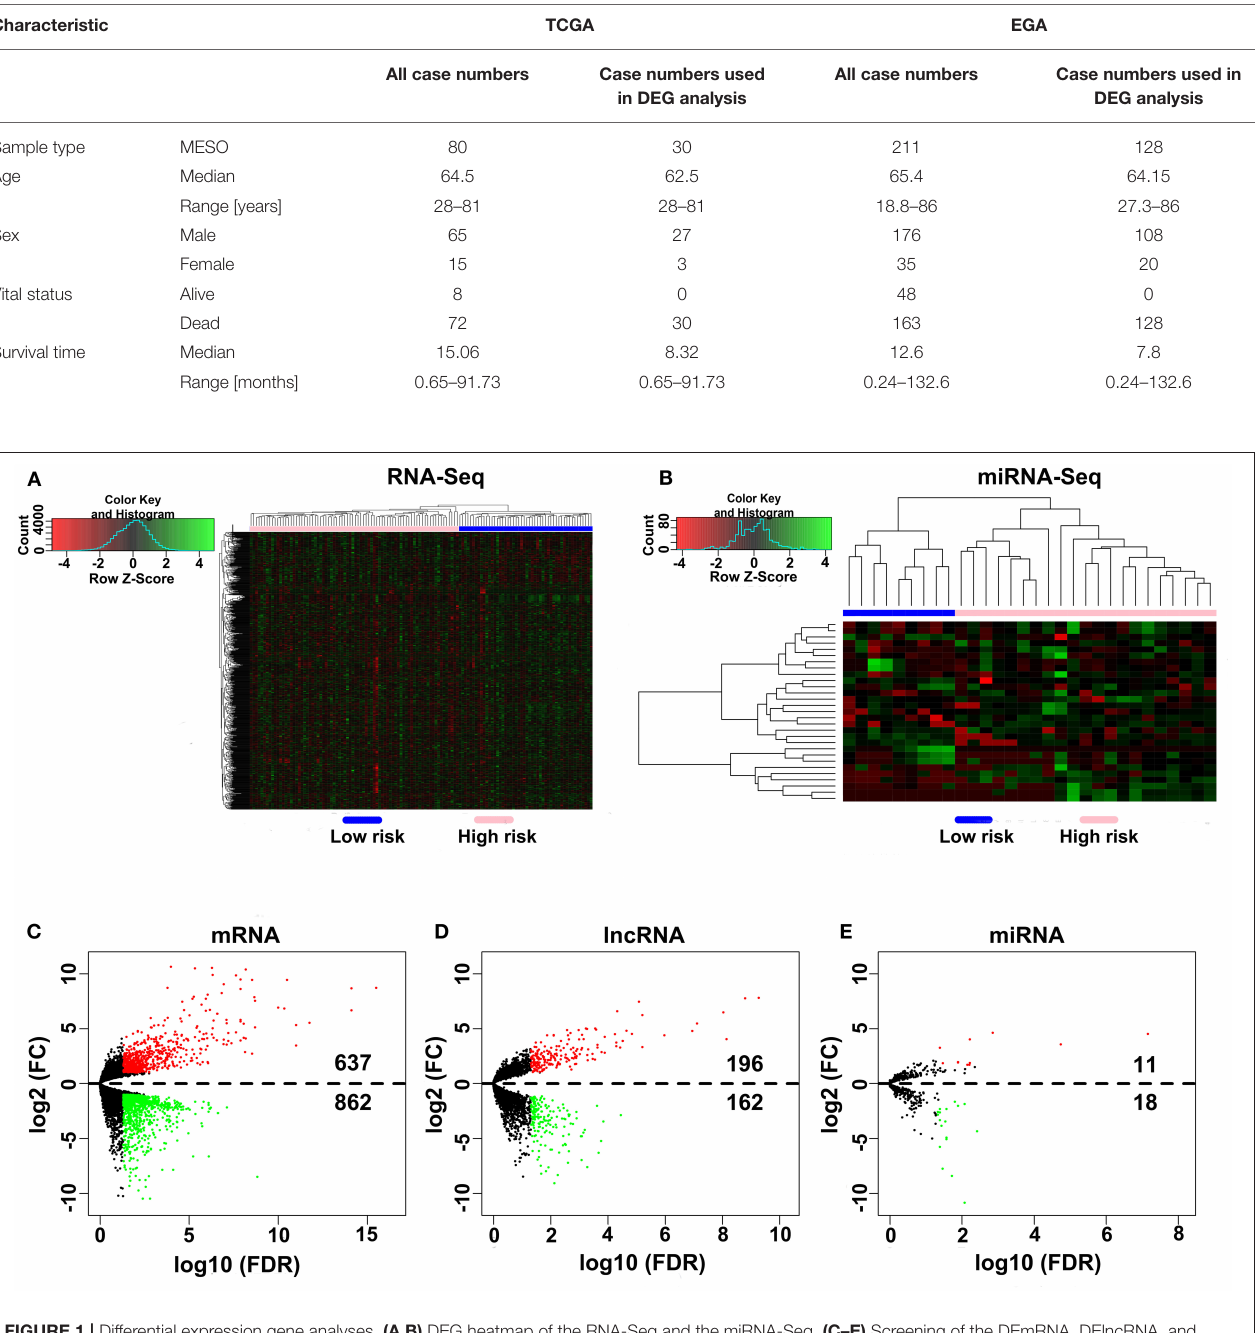
TABLE 1 | The characteristics of the included MPM patients.